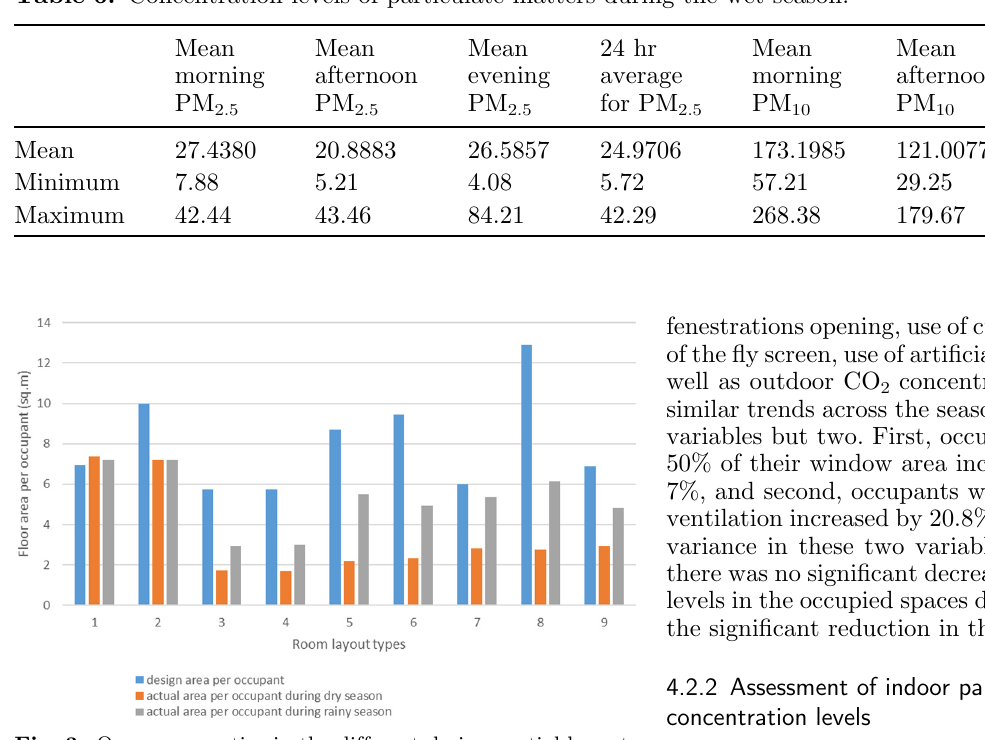
Fig. 3. Occupancy ratios in the different design spatial layouts across the seasons.